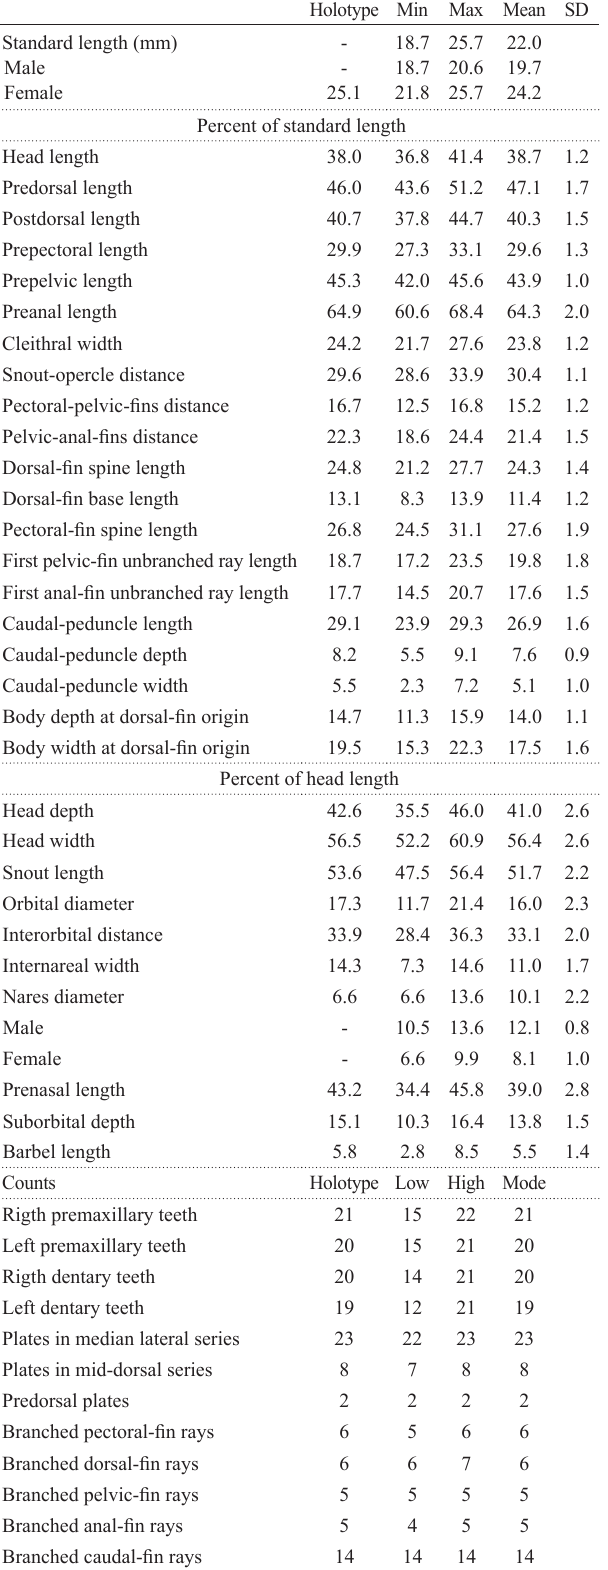
inconspicuous blotches and leaving lighter areas. Dark brown lateral stripe from side of snout, crossing eye and ending at end of caudal peduncle, clearly delimiting white ventral